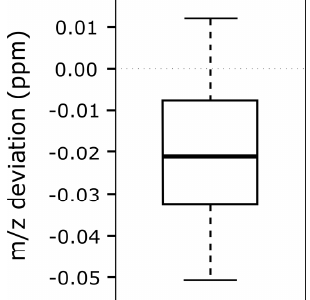
Figure 8. Box-plot showing the differences between imposed and detected mass-to-charge ratio ( m / z )